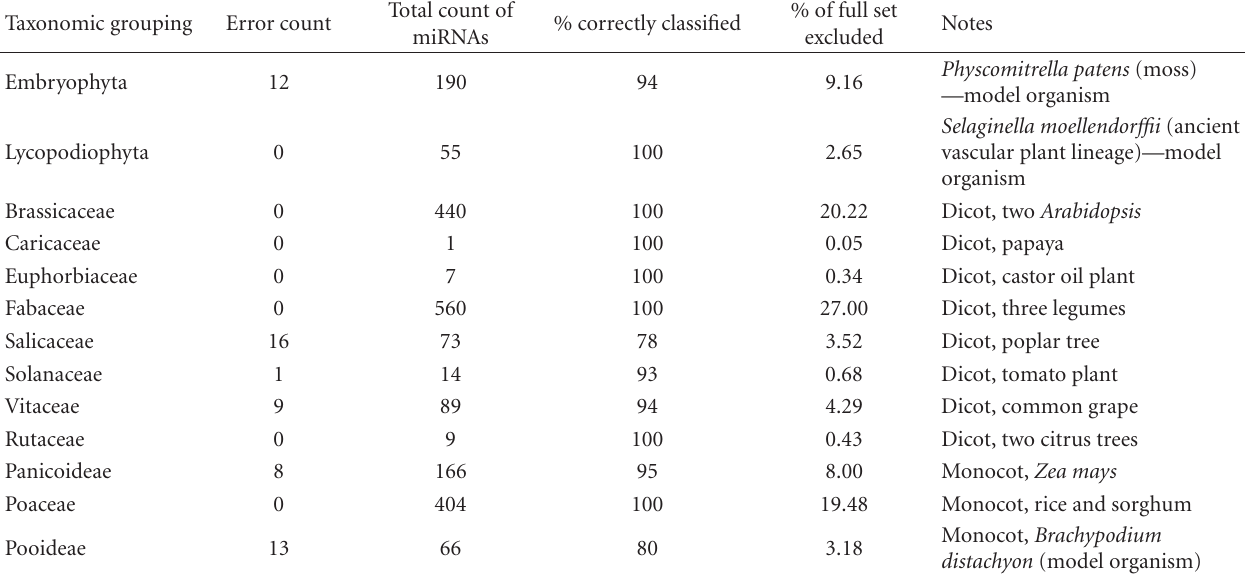
Table 7: Results from exclusion of each of the 13 taxonomic groups.